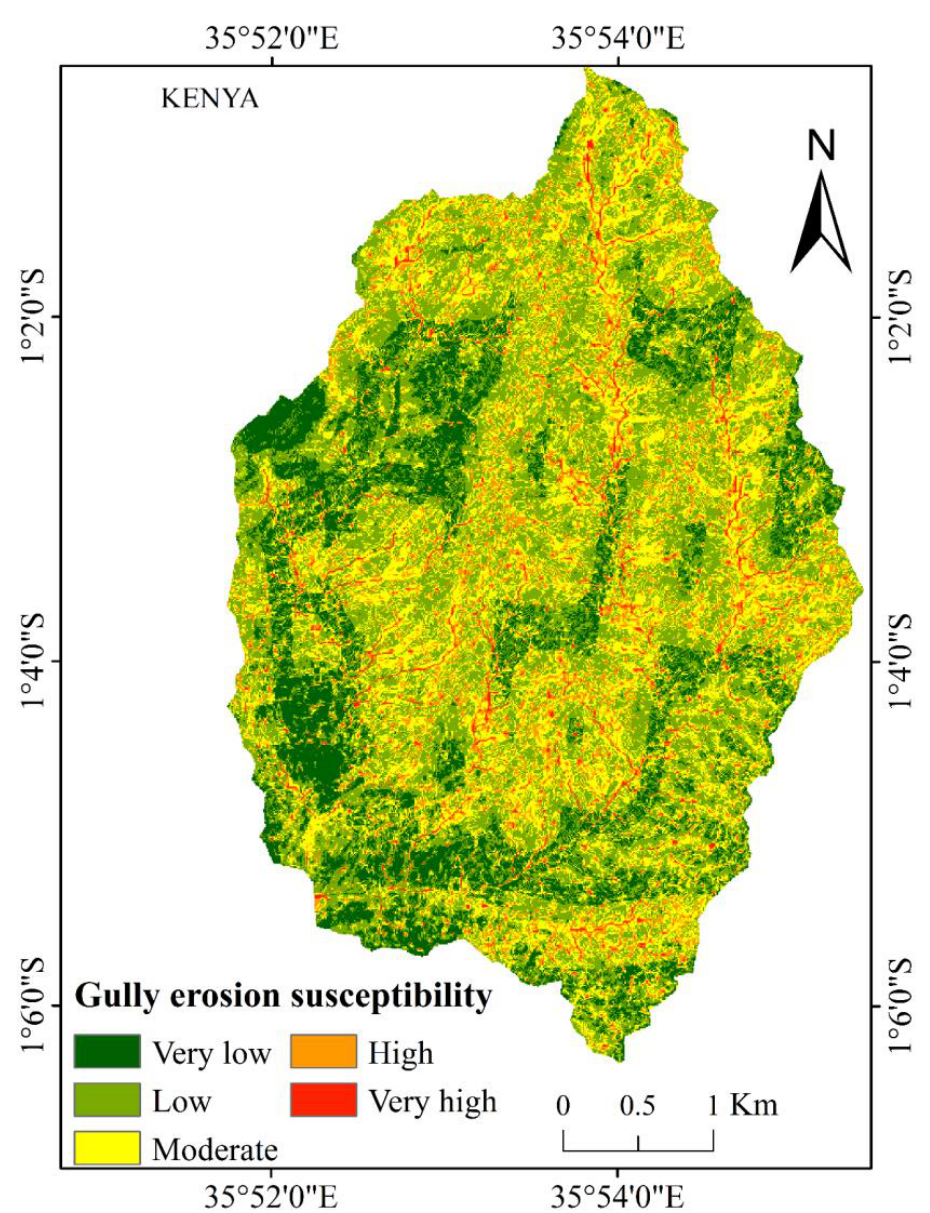
Figure 8. Map of gully erosion susceptibility of Kakia-Esamburmbur catchment using LR.